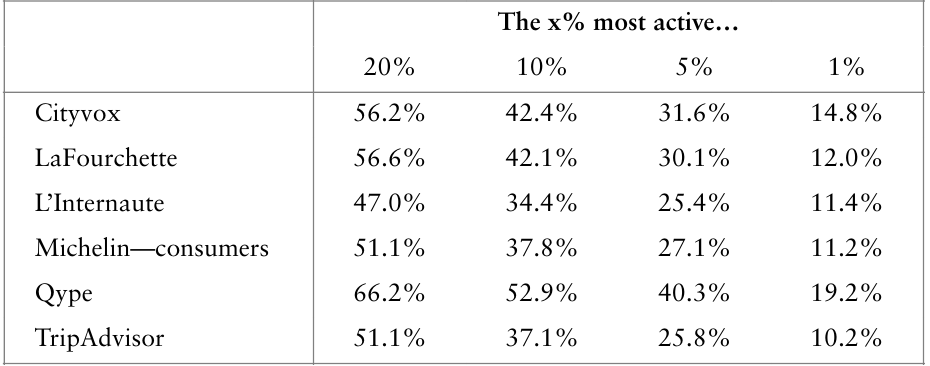
Table 8. Proportion of ratings made by the x% of most active contributors.